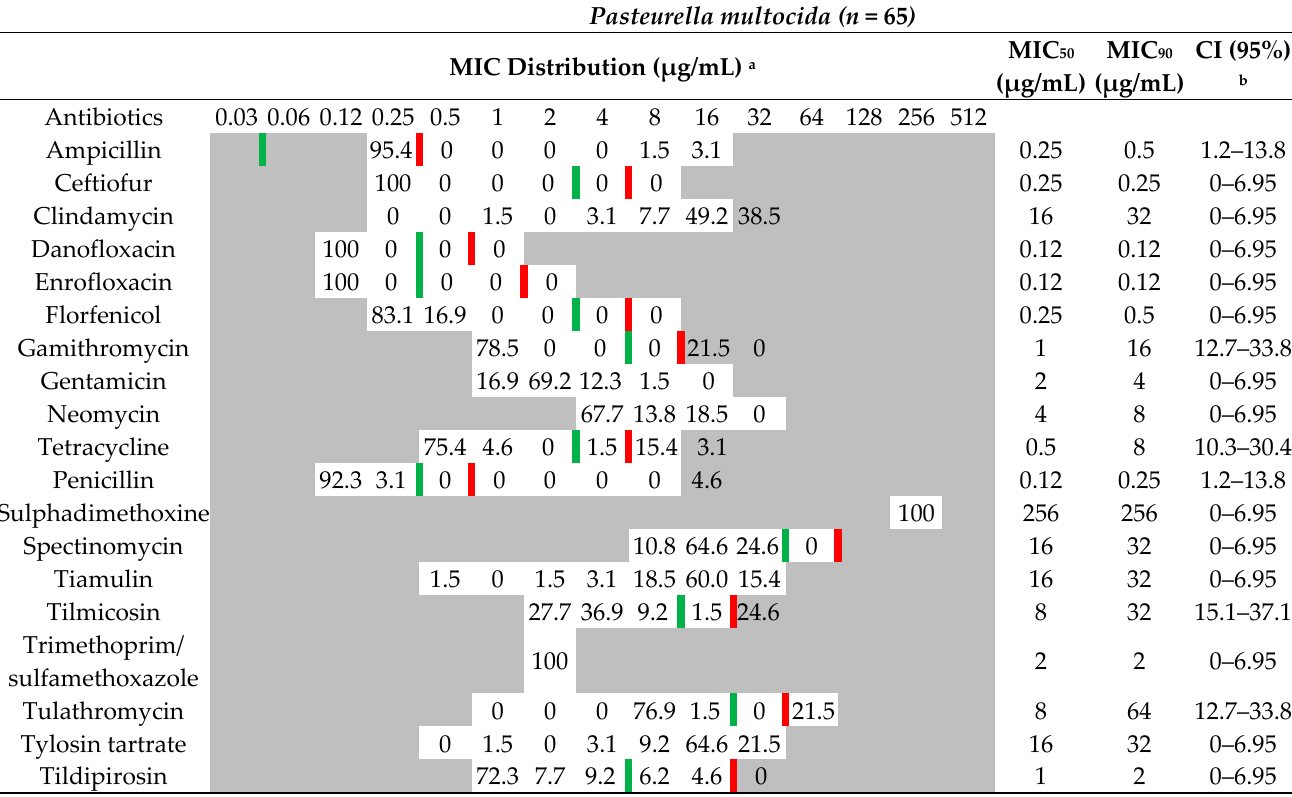
Table 6. MIC distribution frequencies of P. multocida cattle isolates from Australia 2019.